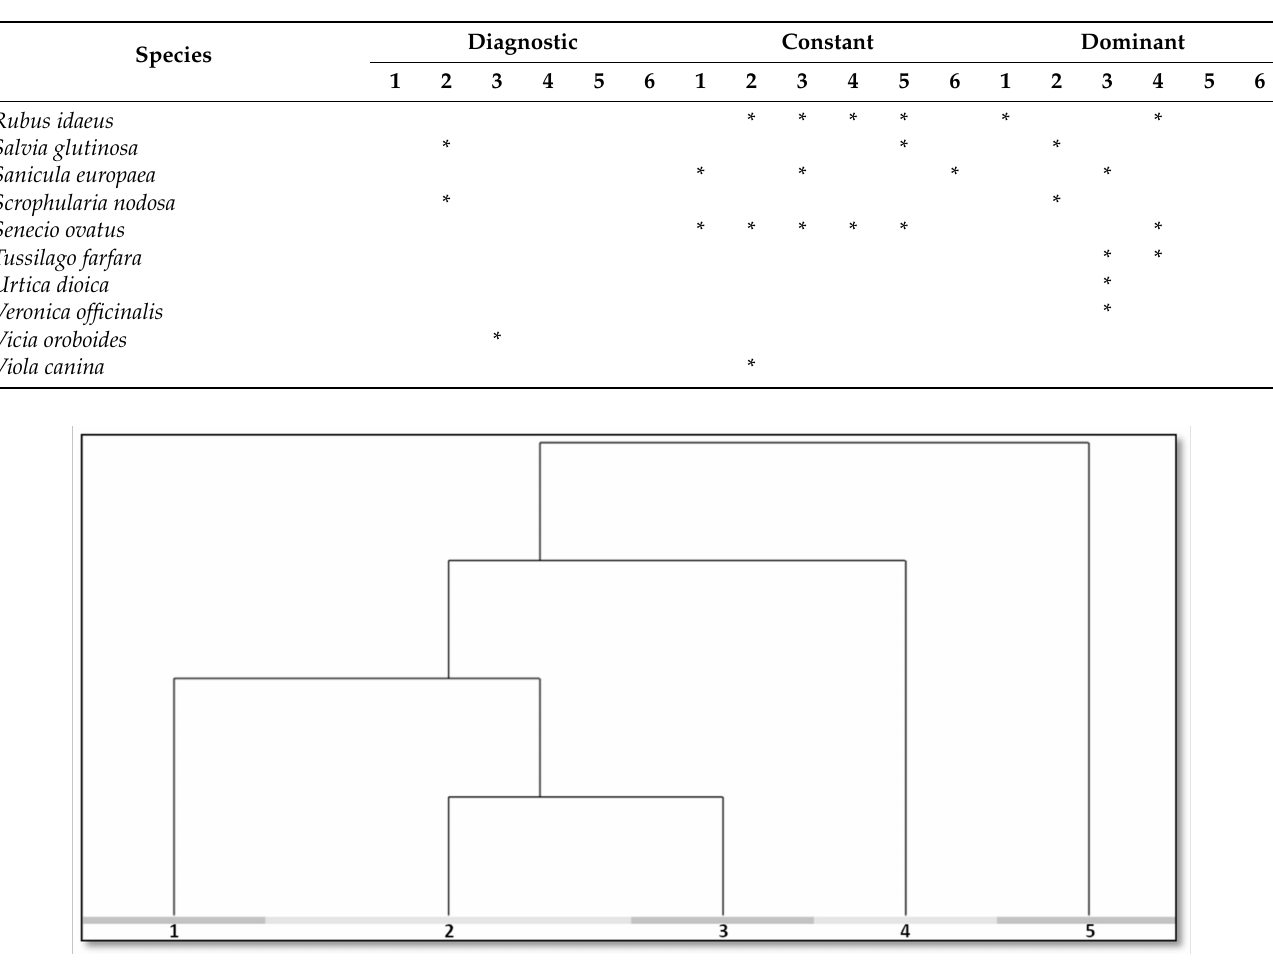
Figure 2. Dendrogram of similarities between individual locations based on Jaccard coefficient (1: control L1-2000; 2: L3-2007 and L4-2013; 3: L5-2011; 4: L2-2007; 5: